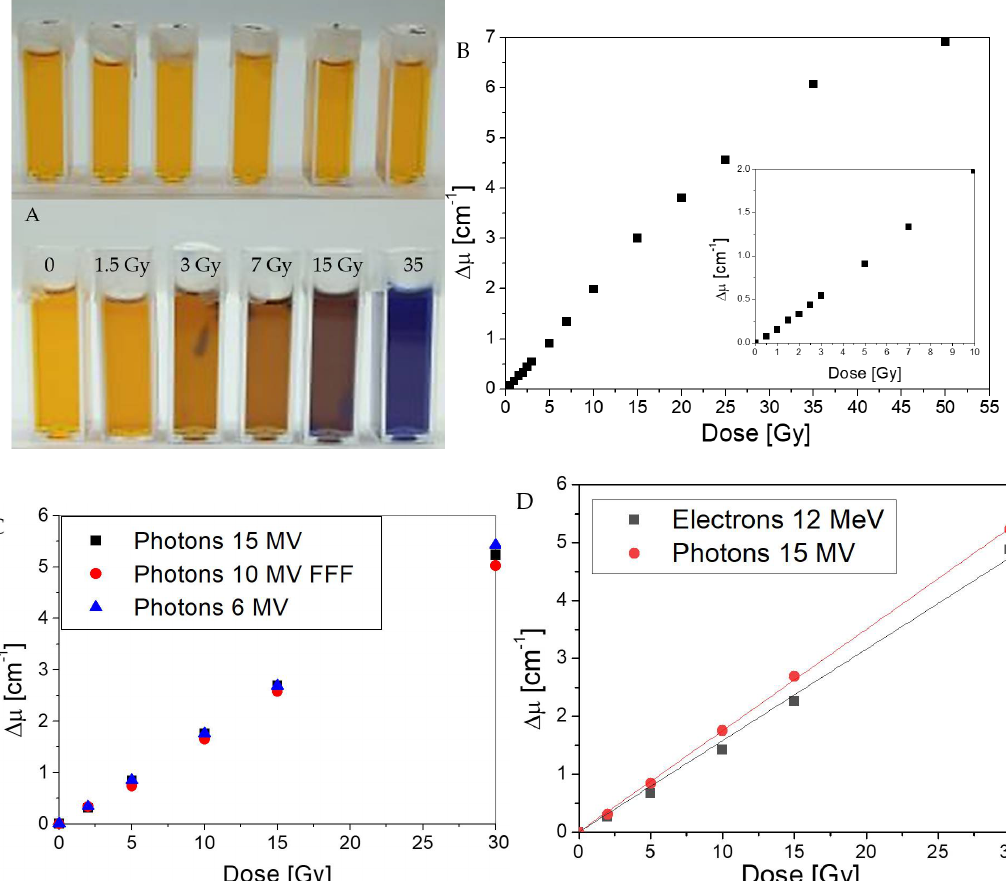
Figure 7. Dose response of Fricke-XO-Pluronic F-127 containing 0.2 M NaCl: ( A )—photographs of dosimeter samples before and after irradiation; ( B )—optical density as a function of radiation dose for the dosimeter; measurements performed about 1 h after irradiation; inset: same relation but for a narrow dose range of 0 – 10 Gy; irradiation was performed with 6 MV photons; ( C )—dose response of the dosimeter for samples irradiated with 6 MV, 10 MV FFF, and 15 MV photons; and ( D )—dose response of the dosimeter for samples irradiated with 15 MV photons and 12 MeV electrons. Table 2. Basic dose response features of Fricke-XO-Pluronic F-127 containing 0.2 M NaCl. Dynamic dose response is up to 50 Gy and dose threshold is lower than 0.5 Gy; 0.5 Gy was the lowest dose applied in this study. Dose sensitivity is understood to be the slope of the linear regression. Dose sensitivity ** and Intercept **are calculated from Absorbance (585 nm) vs. dose relations (not shown